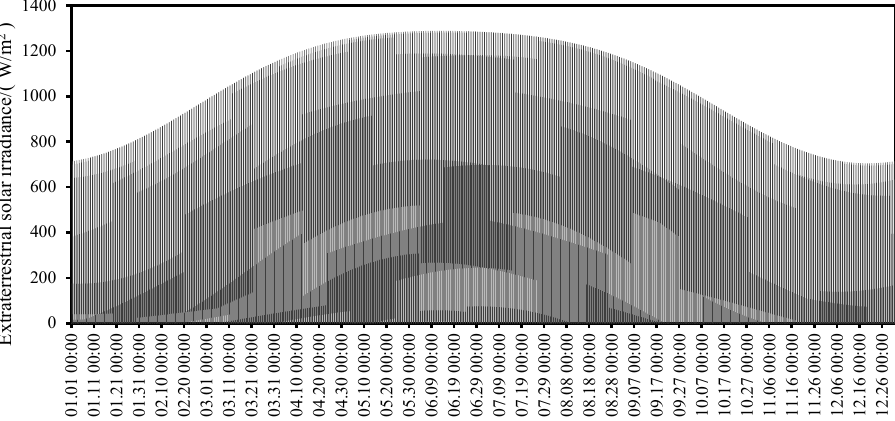
Figure 6. Hourly extraterrestrial horizontal solar radiation changes in 2020 in Lanzhou New District.